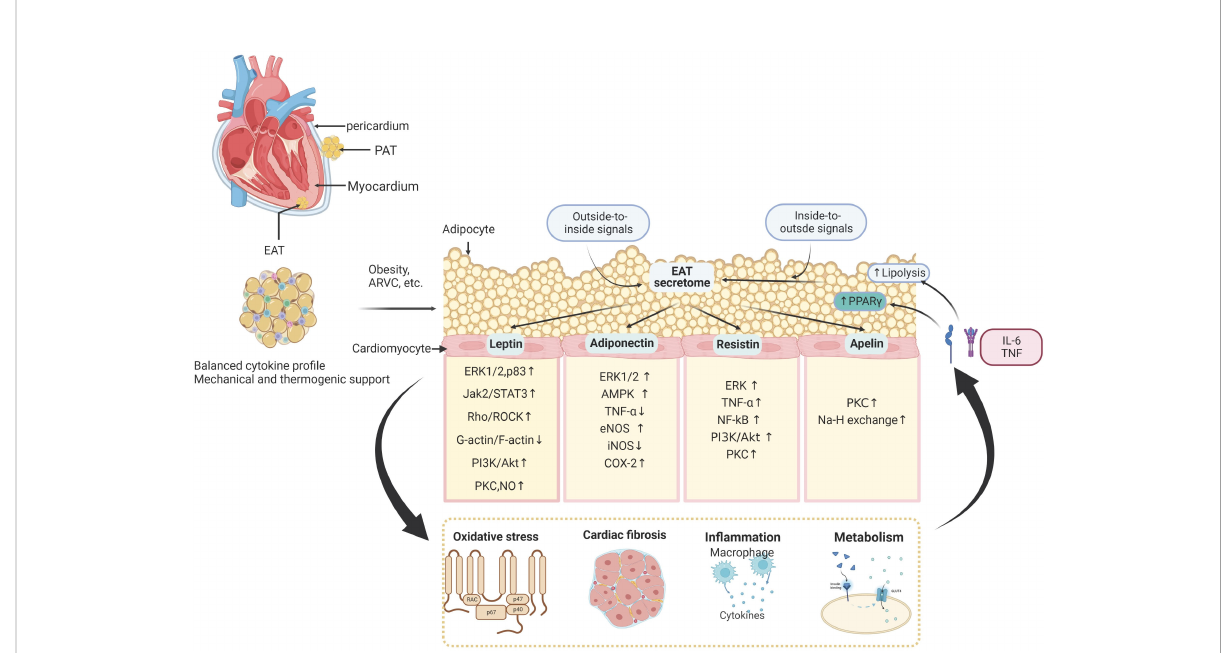
FIGURE 2 The molecular signaling interplay between the adipose tissue and cardiomyocytes. The epicardial adipose tissue (EAT) lies on the surface of the human heart inside the visceral pericardium, and interacts with adjacent cardiomyocytes and extracellular matrix in a paracrine manner. EAT interacts with the cardiovascular system by releasing amounts of cytokines, including leptin, adiponectin, resistin, apelin, nitric oxide, interleukins, tumor necrosis factor-a (TNF-a), and other in fl ammatory factors. These EAT-derived molecules are involved in several biological processes in the myocardium, such as oxidative stress, cardiac in fl ammation, fi brosis, and cardiac metabolism. In addition to these outside-to- inside signals, vascular in fl ammation and oxidative stress can also affect adipose tissue biology in an inside-to-outside manner. PAT, Pericardial Adipose Tissue; ERK1/2, extracellular signal-regulated kinases 1/2; Jak2/STAT3, Janus kinase 2/signal transducer and activator of transcription 3; Rho/ROCK, Ras homolog gene family member; PI3K/Akt, phosphoinositide 3-kinase/protein kinase B; PKC, protein kinase C; NO, nitric oxide; TNF, tumor necrosis factor; eNOS, endothelial nitric oxide synthase; COX-2, cyclo-oxygenase-2; NF- k B, nuclear factor- k B; AKT, RAC a serine/ threonine-protein kinase; AMPK, 5 ′ -AMP-activated protein